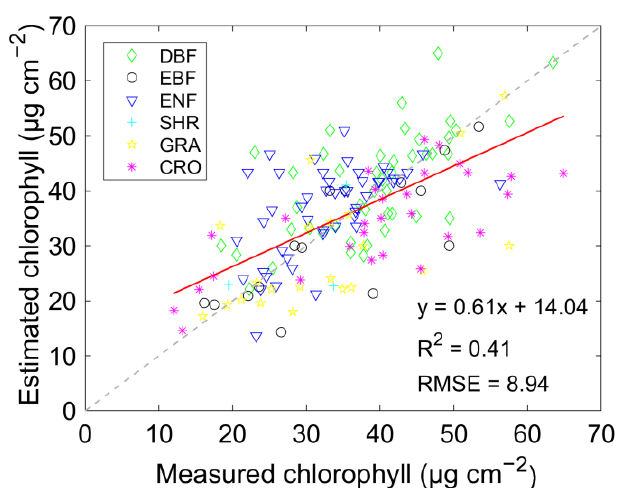
Figure 5. Validation of the GLCC dataset with field measurements for all PFTs.